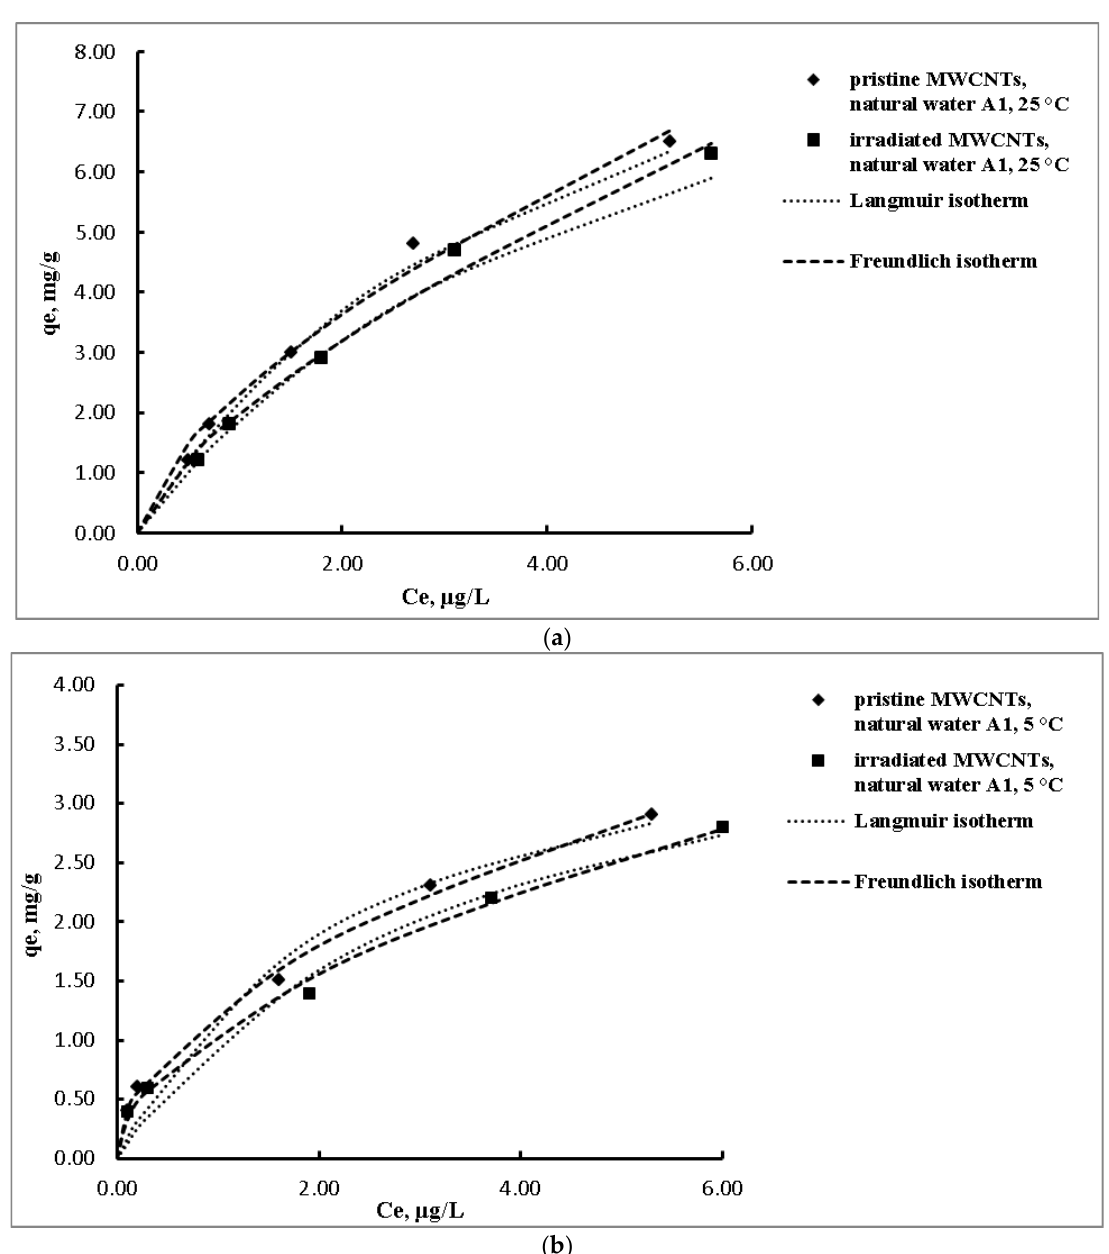
Figure 1. Langmuir and Freundlich non-linear adsorption isotherms in natural surface water A1 at 25 °C ( a ) and 5 °C ( b ).